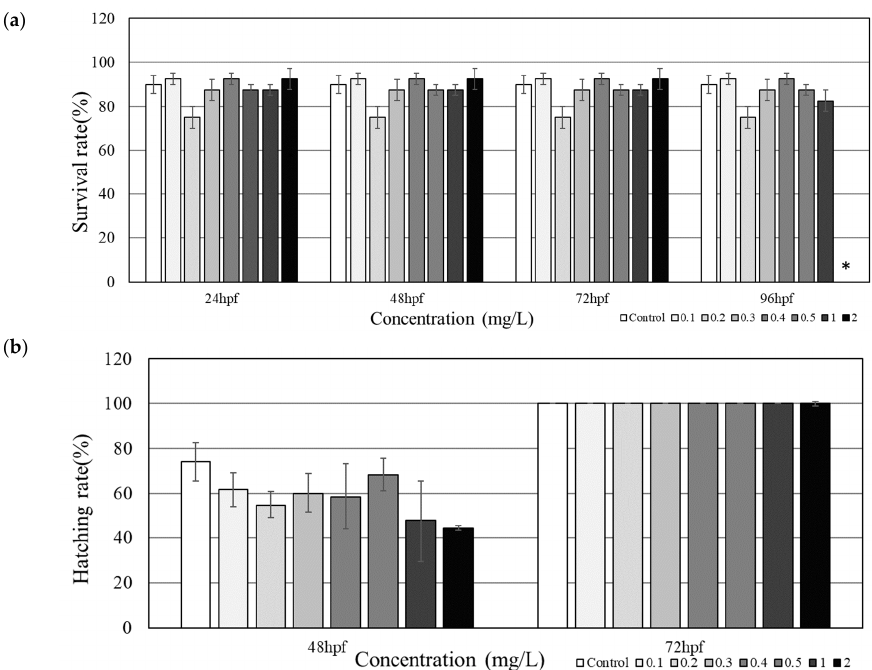
Figure 1. Survival ( a ) and hatching rate ( b ) of zebrafish embryos / larvae under polyhexamethylene guanidine-phosphate (PHMG-P) exposure ( N = 10). Asterisks (*) denotes statistical significance ( p < 0.05).